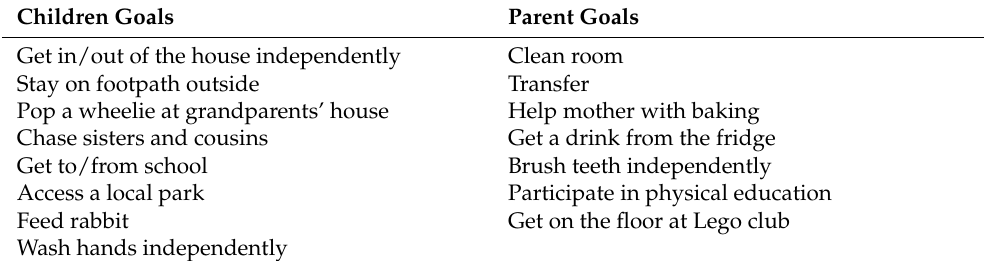
Table 2. Goals related to wheelchair use as identified by PWCUs and parents.